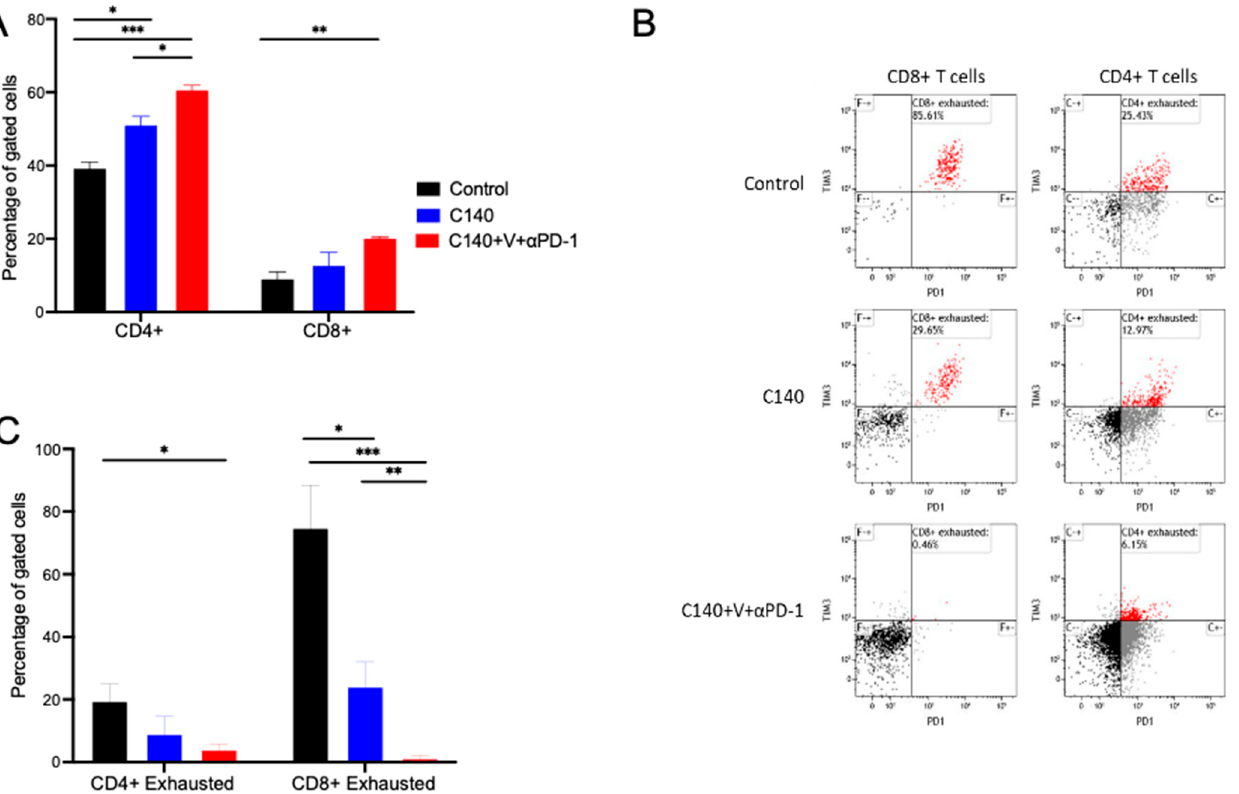
Figure 3. TT reshapes tumor infiltrating lymphocytes and reduces exhausted CD3 + CD4 + and CD3 + CD8 + T cells. ( A ) Percentage of CD3 + CD4 + and CD3 + CD8 + cells in the spleen of control (black), C140- (blue), and C140+V+anti-PD-1-treated mice (red). The Shapiro–Wilk test was performed to assess normal distribution, and thus 2-tails Student’s t test’ was applied. (* p < 0.05, ** p < 0.01, *** p < 0.001) (n = 5 per experimental condition). ( B ) Representative flow cytometry plots showing the percentage of exhausted CD3 + CD8 + cells (defined as CD3 + CD8 + PD-1 + TIM3 + , on the left) and of exhausted CD3 + CD4 + cells (defined as CD3 + CD4 + PD-1 + TIM3 + , on the right) within the spleen of a control (upper panel), C140- (middle), and C140+V+anti-PD-1-treated mouse (bottom panel). Cells were gated according to physical parameters. ( C ) Quantification of exhausted CD3 + CD8 + cells (defined as CD3 + CD8 + PD-1 + TIM3 + ) and of exhausted CD3 + CD4 + cells (defined as CD3 + CD4 + PD-1 + TIM3 + ) within the spleen of control, C140-treated, and